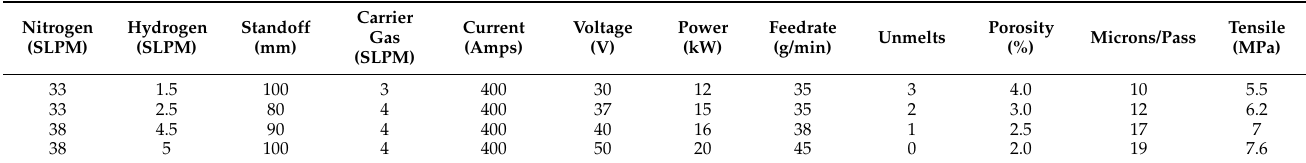
Table 1. Parameter trials with four sets of parameters